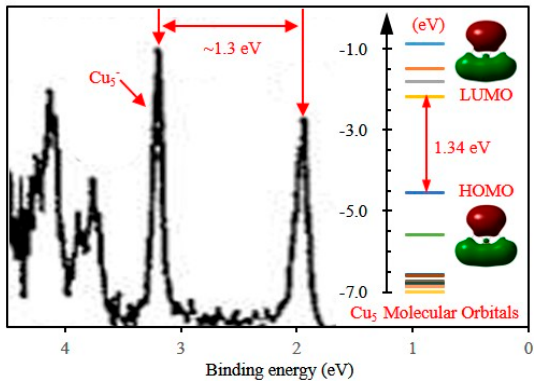
− cluster, which is cited from Ref. 5